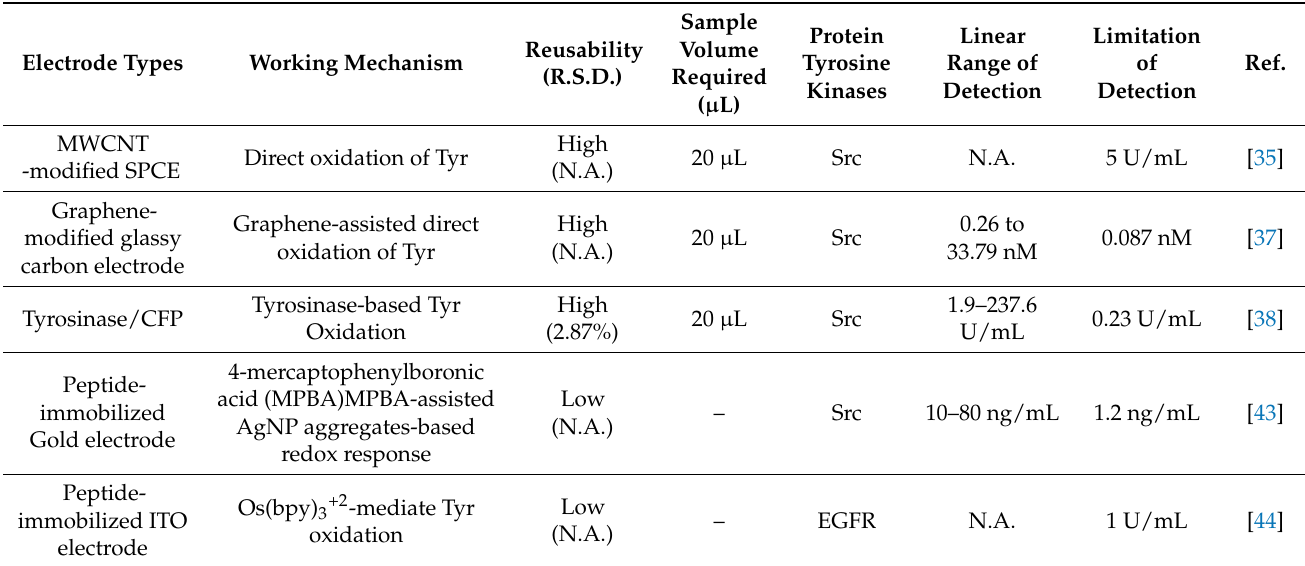
Figure S3. The chronoamperometric measurement of substrate peptides for Hck and Her2; Figure S4. Reproducibility of tyrosine kinase sensing